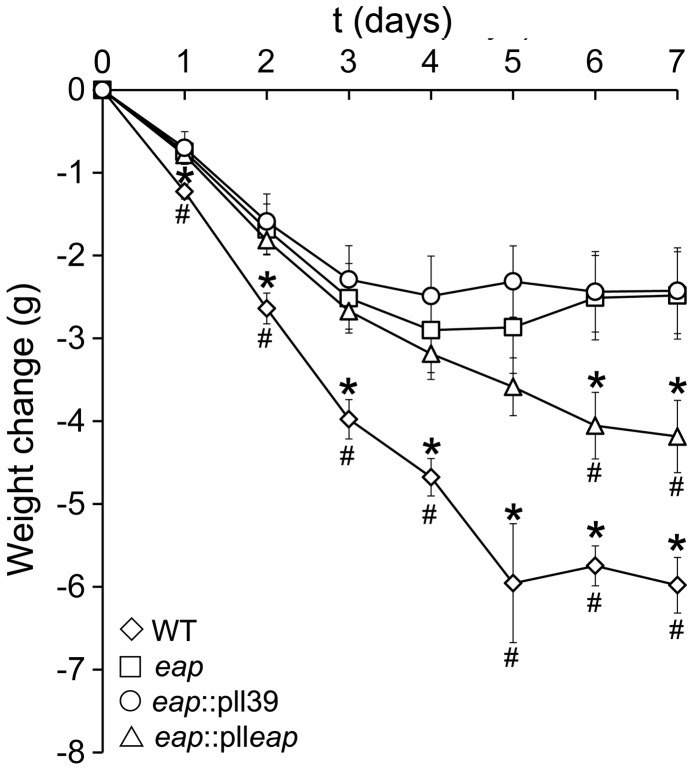
Eap is a virulence factor in a murine bacteremia model.Mice were challenged with Newman wild-type (WT), mAH12 (eap-), mAH12 (pll39) and mAH12 (plleap) and their weight monitored over 7 days. Error bars represent the standard deviation of the mean. Values that are significantly different (p<0.05) from mAH12 (eap-) are highlighted with an *, and those significantly different (p<0.05) from mAH12 (pll39) with a #.